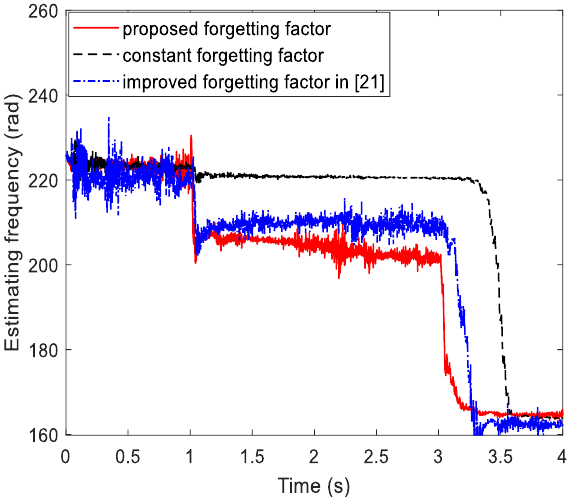
Figure 8. Resonance frequency